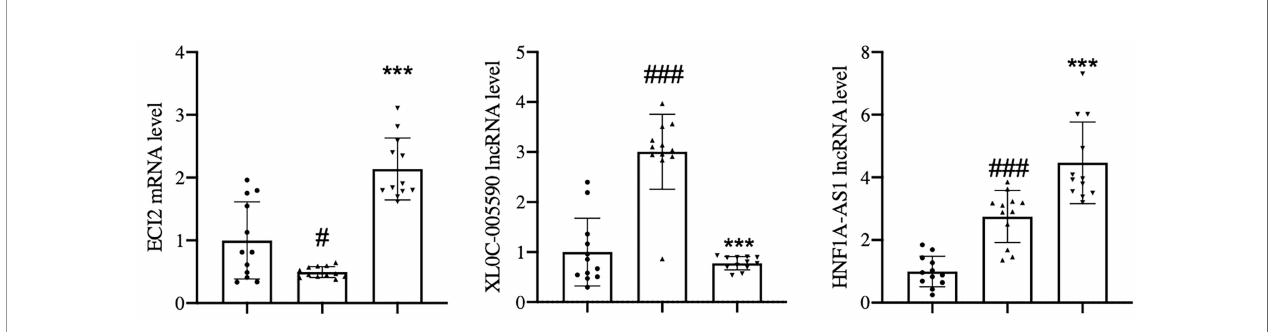
FIGURE 14 | qPCR was used to verify the expression of XLOC_005590 and ECI2 in the healthy control group, and the disease group before and after treatment. The left column represents the healthy control group, the middle column represents the disease group before treatment, and the right column represents the disease group after treatment. The normalization using b -actin. # P < 0.05, ### P<0.001, versus the healthy control group. ***P < 0.001, versus the before treatment group;